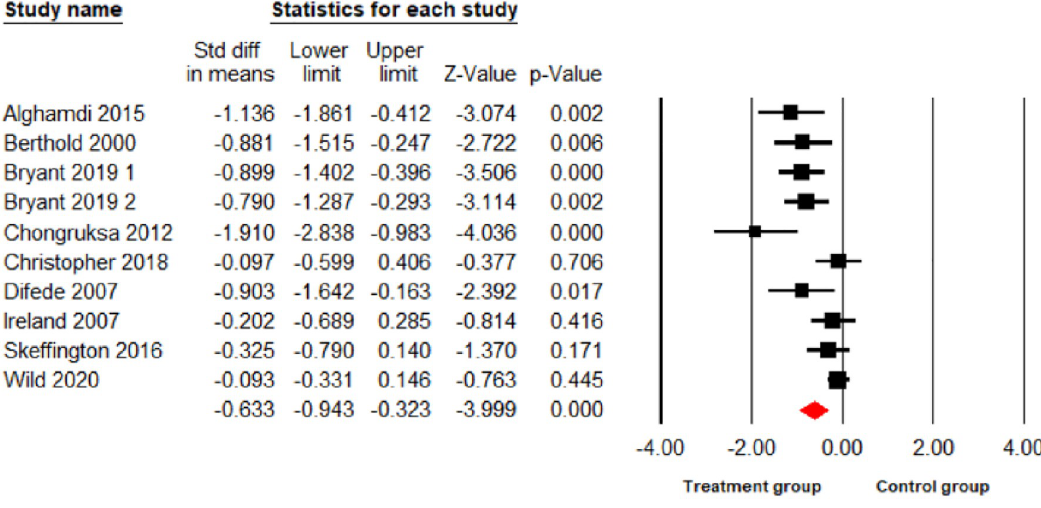
Fig 3. Forest plot for the effect of interventions on depression